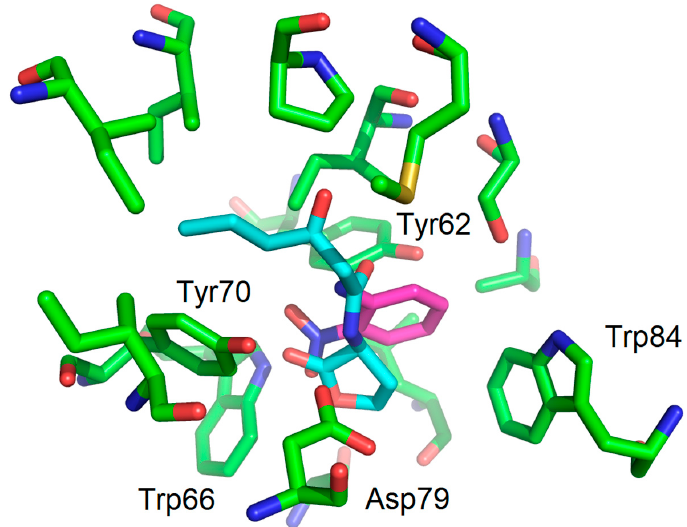
Figure 2. Proposed binding mode obtained as a result of docking experiments of 2-NA (magenta) within the LuxR model binding site. OHHL is also represented, in cyan. Docking experiments were performed using ArgusLab as software with a genetic algorithm as the docking engine (GADock) (see experimental section).